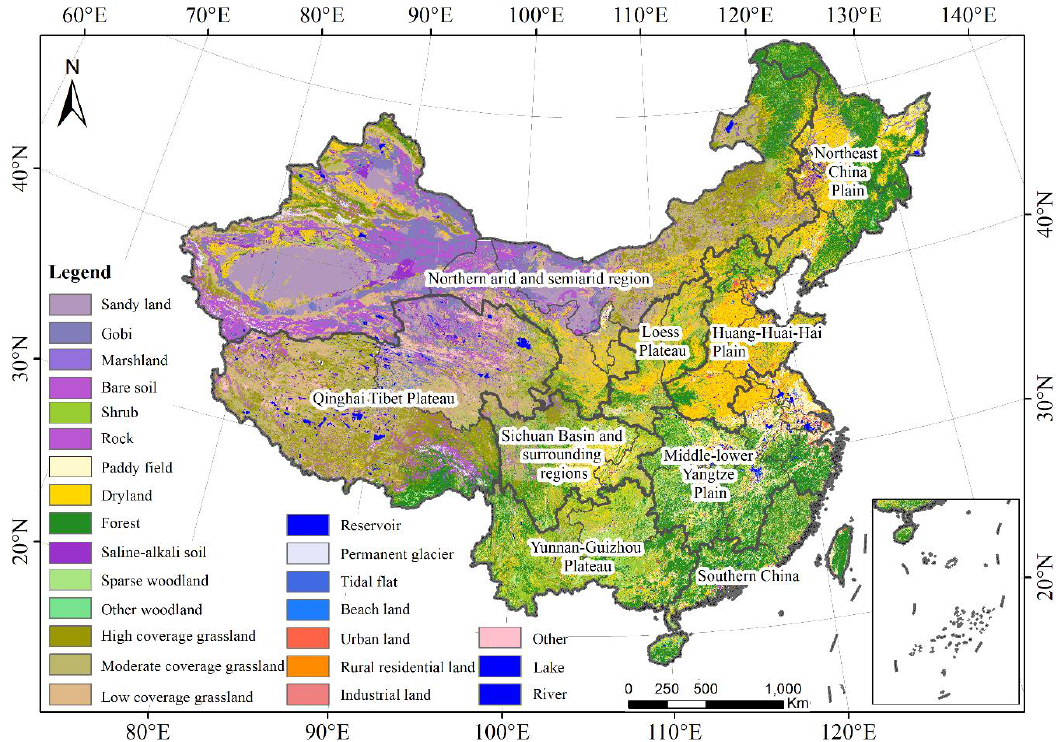
Figure 1. The map of nine agricultural zones in China with a backdrop of the Chinese land cover map. Both maps were obtained from the Resource and Environment Data Cloud Platform (http://www.resdc.cn/) supported by the Institute of Geographic Sciences and Natural Resource Research in the Chinese Academy of Sciences.